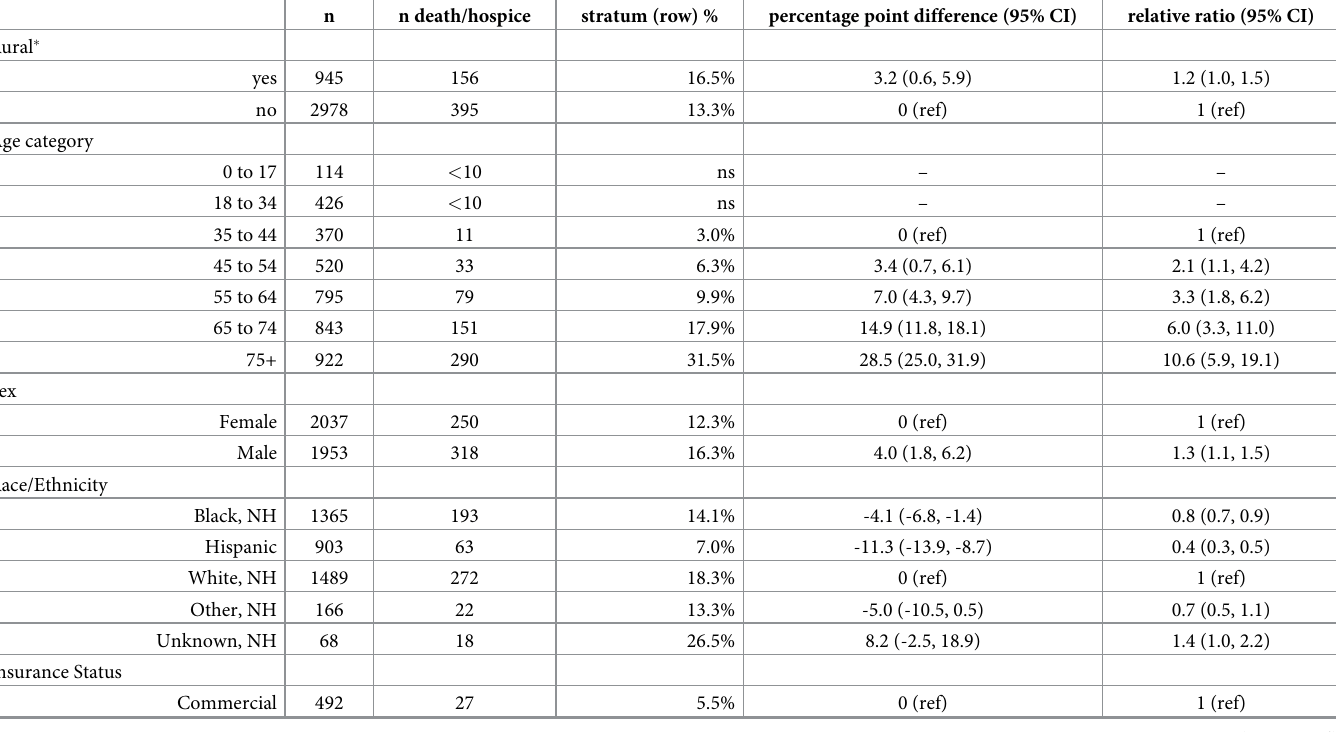
Table 2. Demographics, characteristics and comorbidities and percentage of death/hospice discharge for patients hospitalized with a SARS-CoV-2 infection or COVID-19 diagnosis. n n